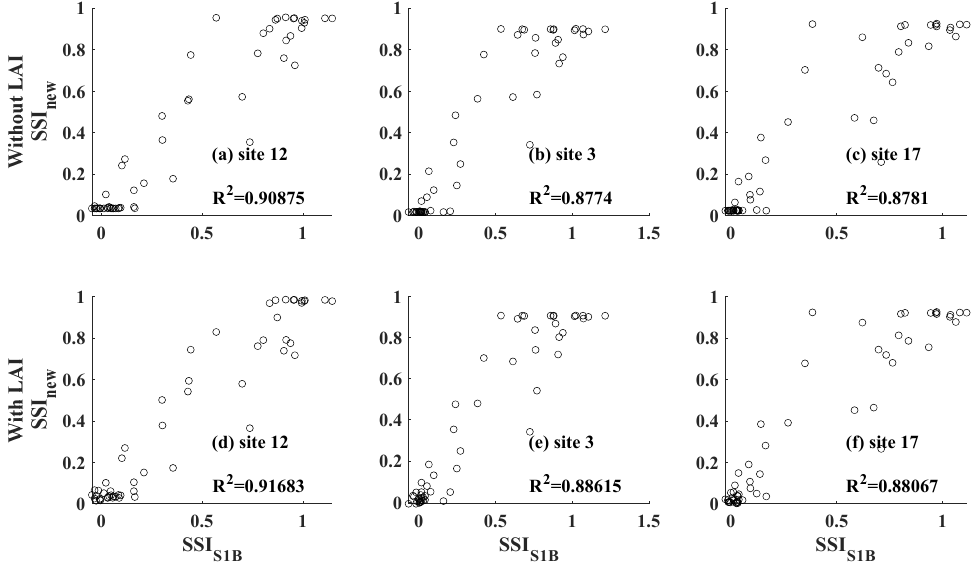
Figure 7. Scatter plot between the SSI S1 and SSI new both considering ( d – f ) and not considering ( a – c ) the LAI for cultivated land (( a , d ), site 12), grassland (( b , e ), site 3), and forest (( c , f ), site 17) over the Genhe watershed.